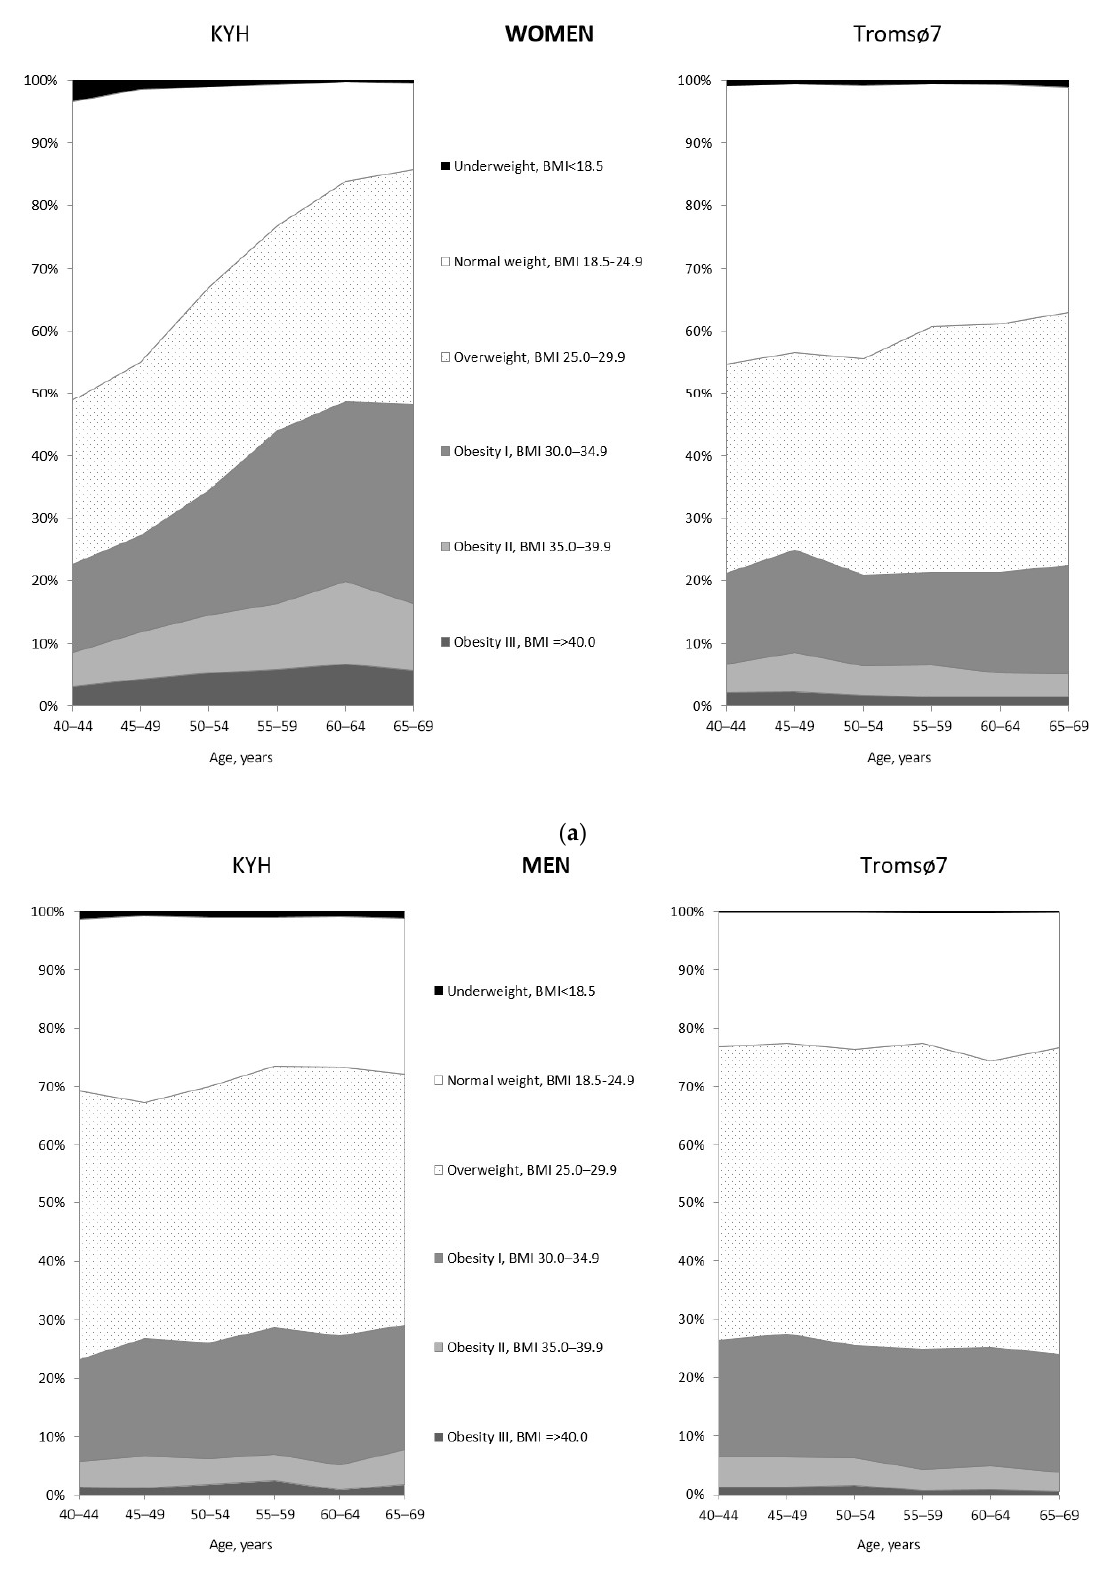
Figure 2. Distribution of women ( a ) and men ( b ) in the compared populations by study, age and BMI categories.